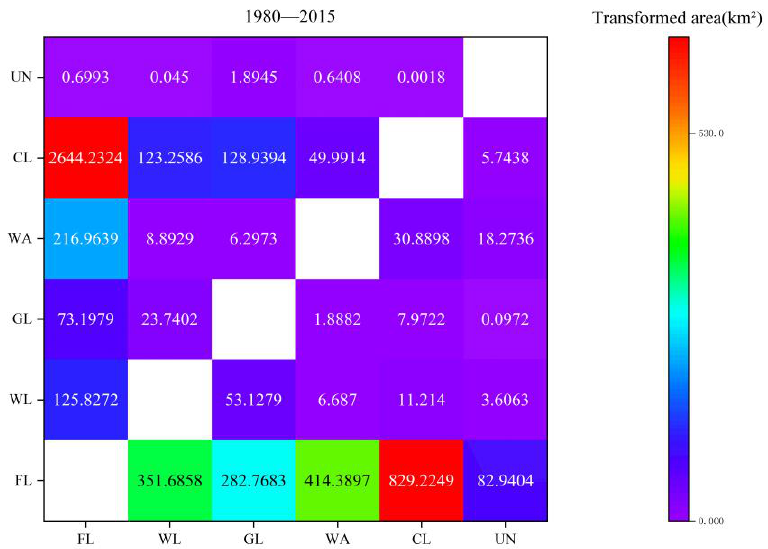
Figure 8. Land use change in different period of 1980 – 2015. Table 2. Transfer matrix of land use area from 1980 to 2015 (km²).